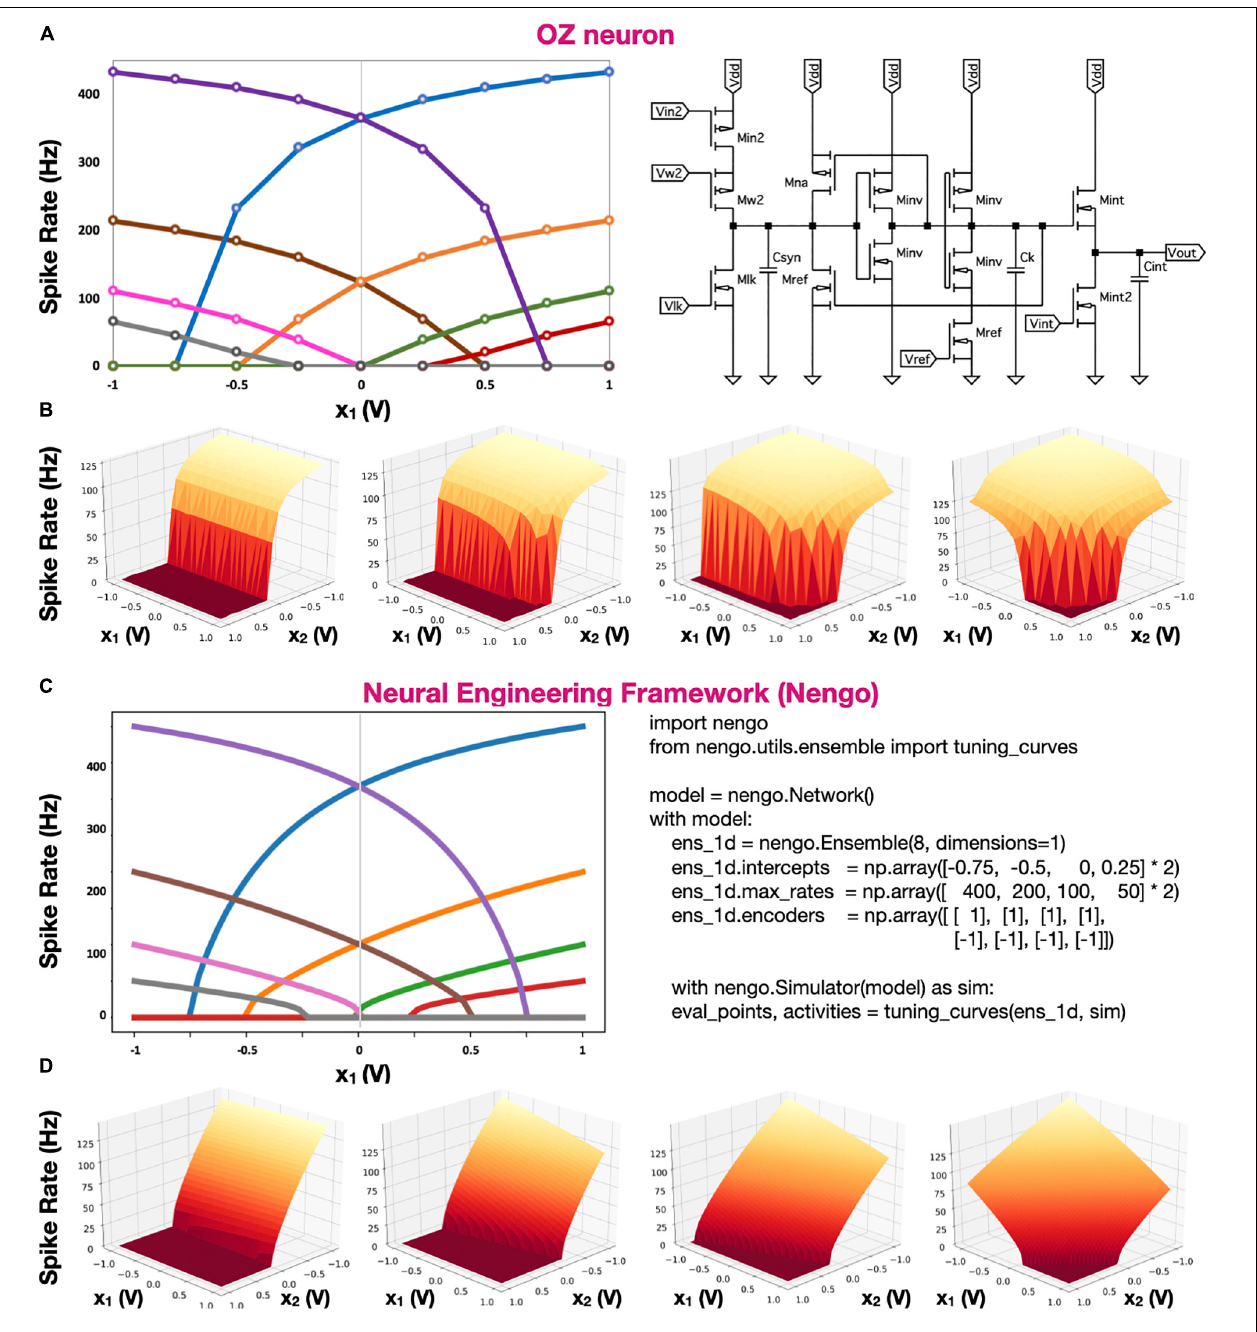
FIGURE 5 | OZ and Nengo neuron tuning curves. (A) Tuning curves of eight 1D hardware-based OZ neurons. (B) Tuning curves of four 2D hardware-based OZ neurons. (C) Tuning curves of eight NEF-based simulated neurons, directly computed with Nengo. (D) Four tunning curves of four 2D simulated neurons (D) . In panels A , C , each color stands for one neuron spiking at a specific rate in response to an input voltage ( x 1 ). In OZ-based 2D representation, V w for x 1 was held constant at 2.5 V, V ref at 0.4 V, and V lk at 0 . 729. V w values for x 2 were 3.3, 2.8, 2.6, and 2.4 V, left to right,